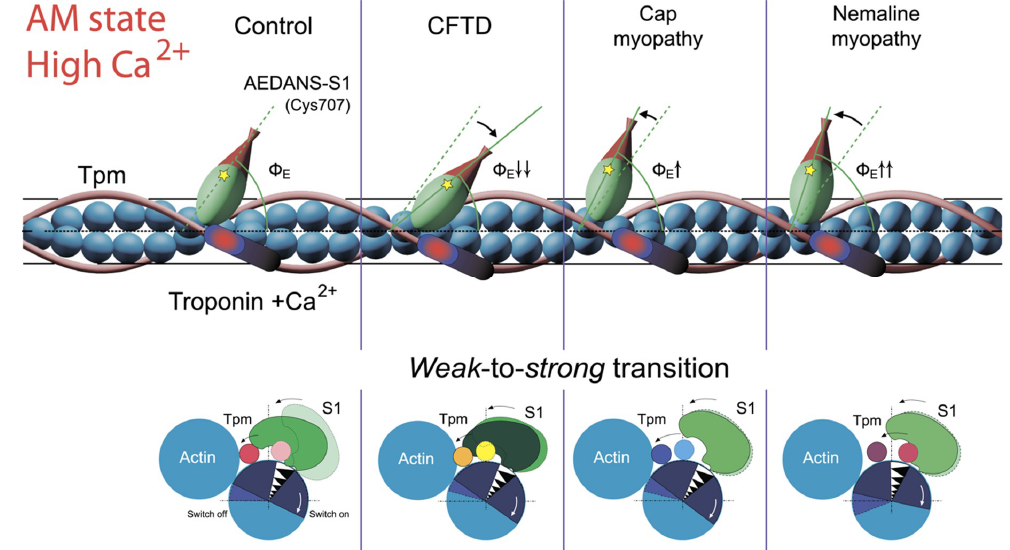
Figure 9. The presumed relationship between changes in the polarized fluorescence parameter Φ E and spatial rearrangements of the proteins in the complex F-actin–Tpm–TN–S1 at high Ca 2+ at simulation of strong and weak binding of S1 to F-actin. Upper panel: a schematic explanation of the proposed conformational changes of the myosin heads at different skeletal myopathies—CFTD, Cap, and NM. The tilt of the myosin head is based on the values of Φ E parameter for S1 modified by 1,5-IAEDANS. Φ E is the angle between the emission dipole of the probe and the thin filament axis. Strong binding of the myosin head to actin is characterized by a decrease in the Φ E parameter and the tilt of the myosin head towards the muscle fiber axis. The increase in the Φ E parameter indicates a decrease in the population of strongly bound myosin heads. Depending on the disease, an increase or a decrease in the population of the myosin heads strongly associated with actin can be observed. Lower panel: A scheme representing the rearrangements of tropomyosin (Tpm), actin monomers, and myosin subfragment-1 (S1) at weak-to-strong transition at different skeletal myopathies. TN is not shown for simplicity. Tpm is shown in different colors depending on the disease; strongly and weakly bound S1 is shown in various shades of green, depending on the strength of its binding to F-actin. The direction of the presumed rotation of actin monomer, axial shift of Tpm strands and translocation of S1 at transitions between the states are shown by arrows. During activation by high Ca 2+ concentration, control Tpm shifts to the inner domain of actin, actin monomer turns away from the filament center (executes a clockwise rotation) and myosin head binds strongly to F-actin (left panel). The substitutions in Tpm associated with different skeletal myopathies modify these